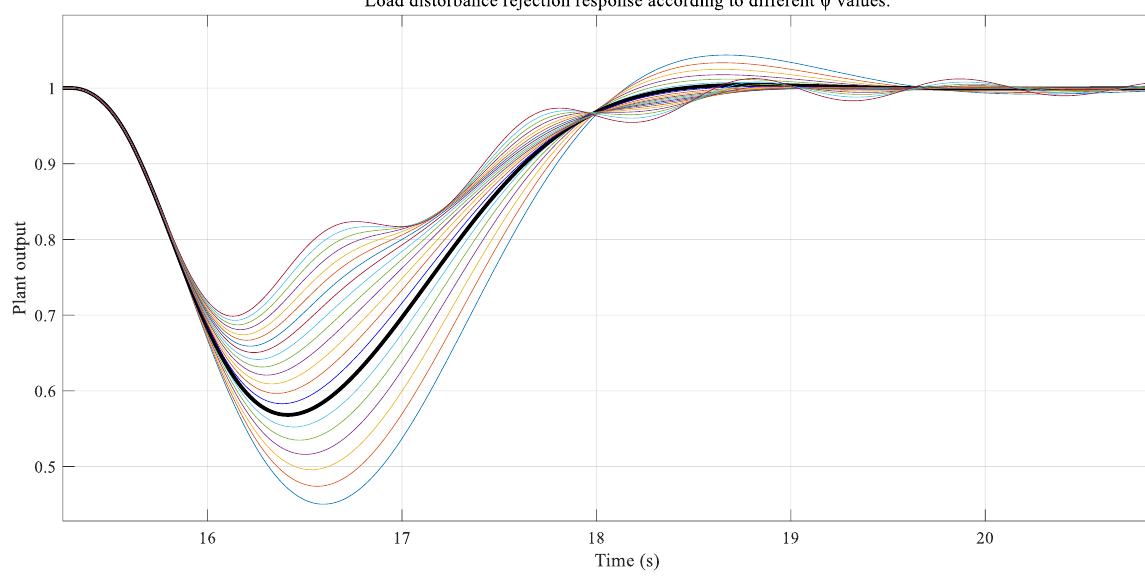
Figure 2. Load disturbance rejection response according to different τ values.